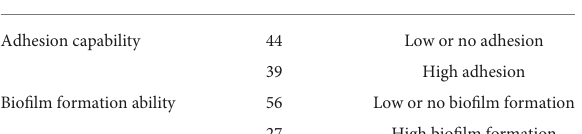
TABLE 3 Classification of the 83 C. jejuni strains according to adhesion capability to abiotic surfaces and biofilm formation ability.